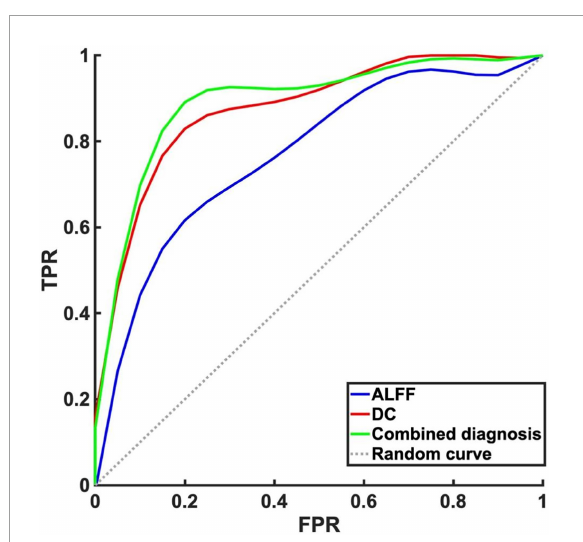
FIGURE4 Receiver operating characteristic curve analysis of amplitude of low-frequency fluctuation (ALFF), degree centrality (DC) and combined diagnosis for altered brain regions. The area under the receiver operating characteristic (ROC) area under the curve (AUC) for ALFF in left precuneus/posterior cingulate gyrus was 0.77 ( P < 0.001, 95% CI: 0.65–0.89), AUC for DC in left insula was 0.88 ( P < 0.001, 95% CI: 0.79–0.96). Combined